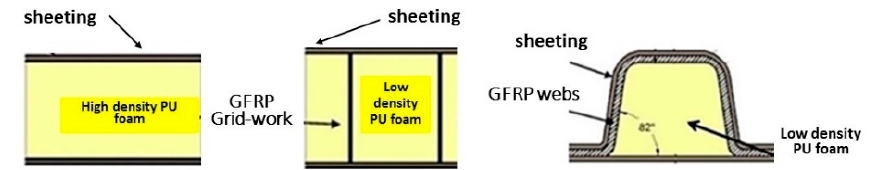
Figure 8. Composite panel con fi gurations for type 1, type 2, and type 3. (left to right) Adapted from [35].